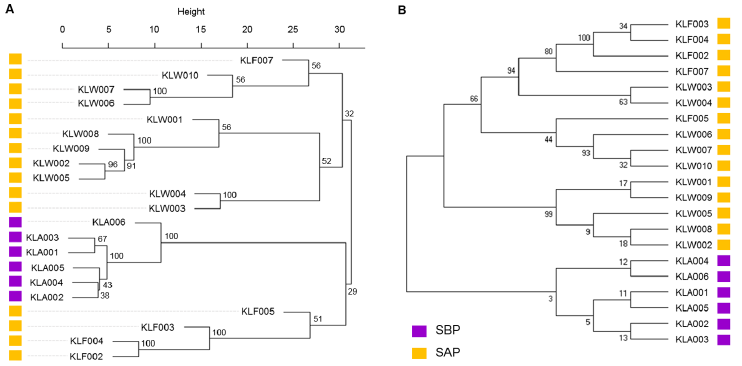
Fig 1. Phylogenetic tree of the isolated L . salivarius strains. (A) Hierarchical clustering of L . salivarius strains based on orthologous CDS contents. (B) Phylogenetic analysisof MLST sequencesfound in the strains. The bootstrapconsensustree inferred from 1,000 replicates is taken.